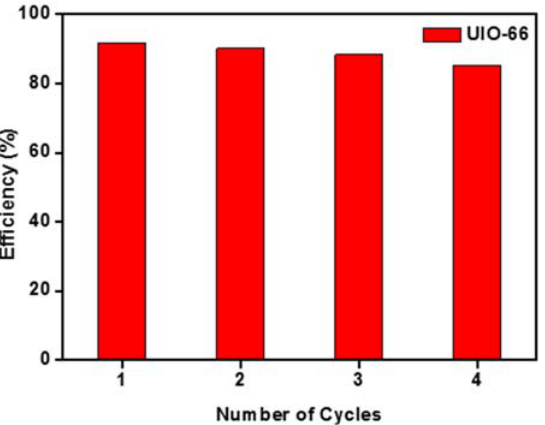
Figure 11. Reduction efficiency of UiO-66 catalysts for catalytic reduction of 4-NP to 4-AP under